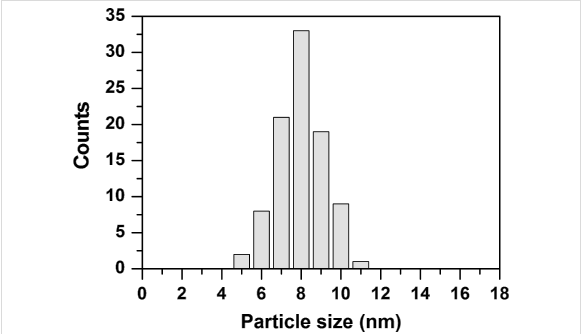
Figure 5: Size distribution of nanoparticles formed from surface-grown copper(II) oxalate after an electron exposure of 8000 μ C/cm 2 at 500 eV. The copper(II) oxalate was prepared by performing 16 deposition cycles. The data have been obtained by measuring the diameter of 90 particles from three different